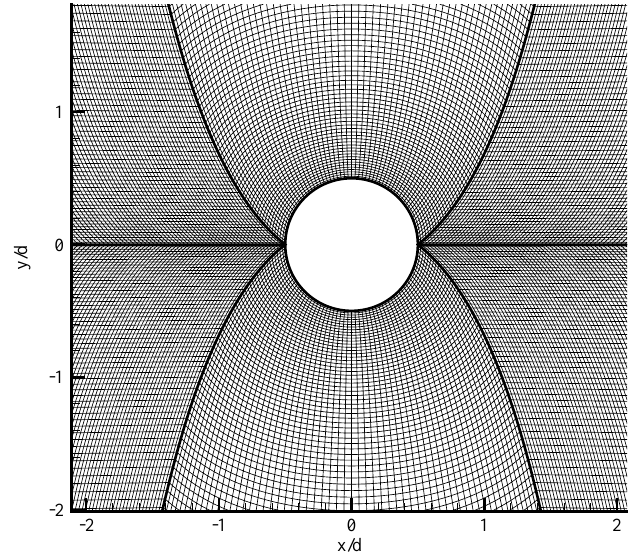
Figure 2. H-topology domain and grid distribution for 2D acoustic scattering; grid points near the cylinder surface (every other point